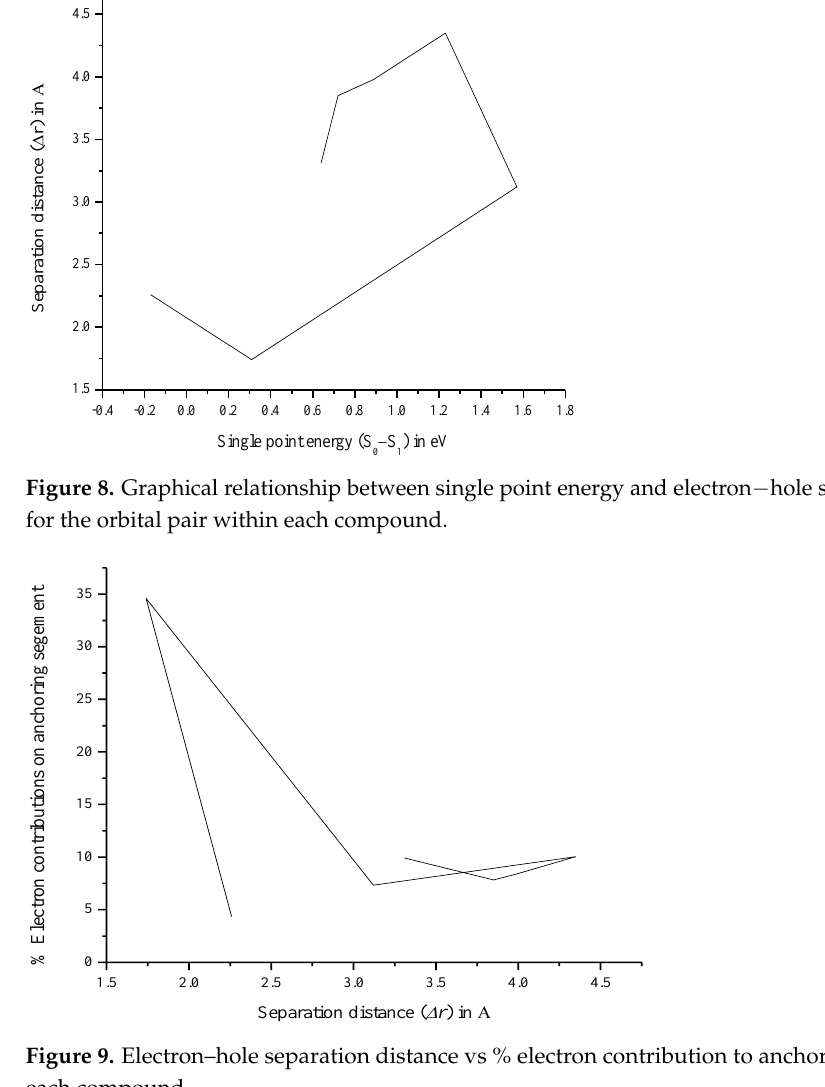
Figure 9. Electron–hole separation distance vs % electron contribution to anchoring groups within Figure 9. Electron – hole separation distance vs % electron contribution to anchoring groups within each each compound.